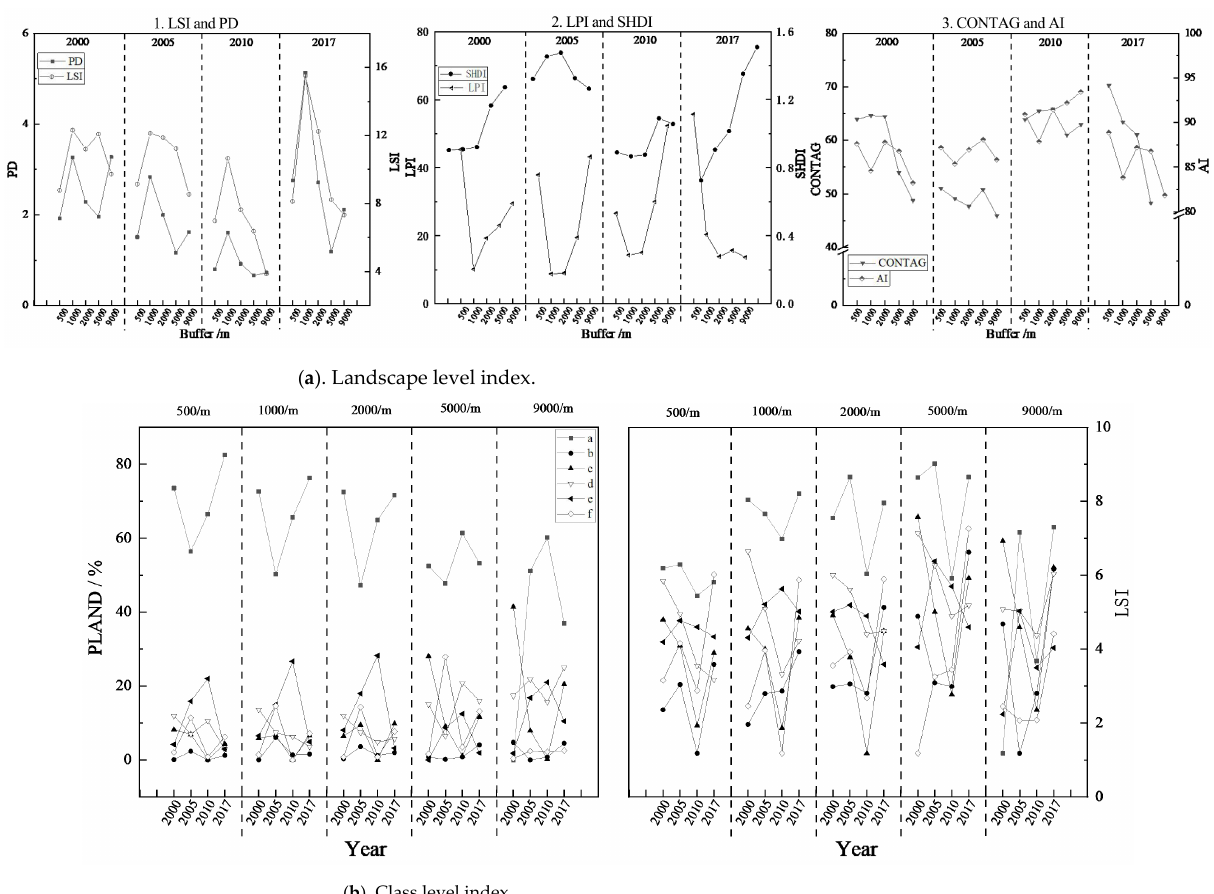
Figure 4. Spatial evolution of rocky desertification patches with different buffers in the industrial areas from 2000 to 2017. Note: a—non-rocky desertification; b—potential rocky desertification; c—light rocky desertification; d—medium rocky desertification; e—severe rocky desertification; f—ex- tremely severe rocky desertification.